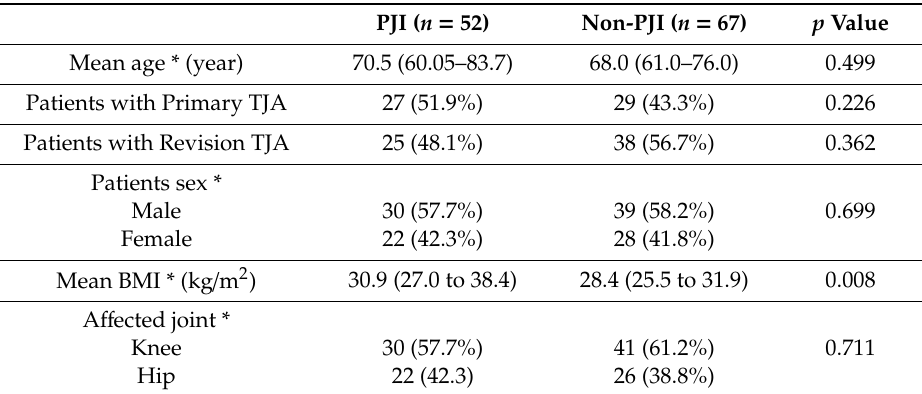
Table 1. Baseline demographics of the enrolled patients.